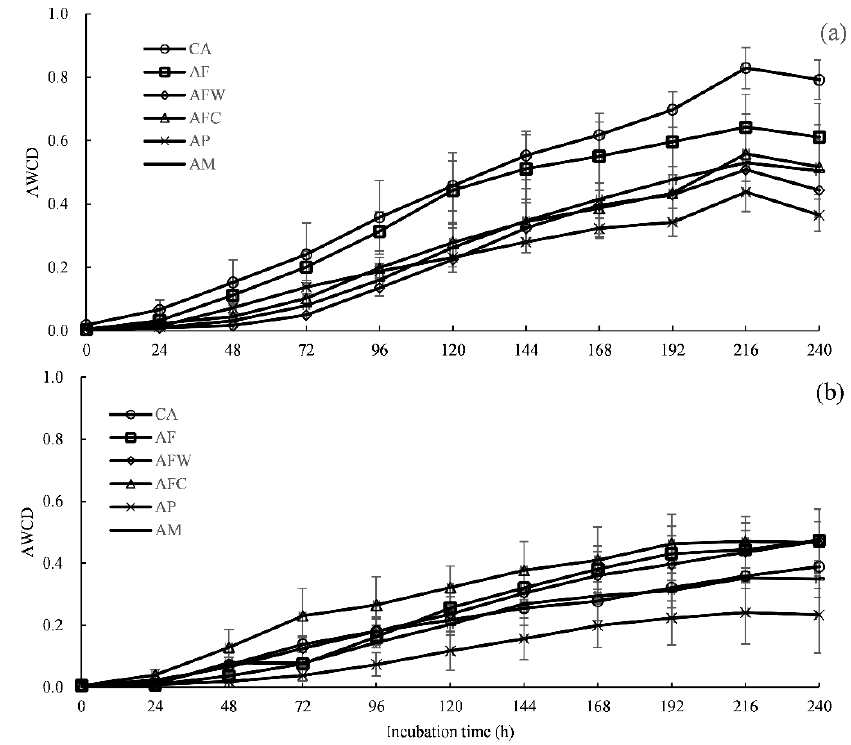
Figure 3. Average well-color development (AWCD) of soil microbial communities with incubation time in the topsoil ( a , 0-30 cm) and subsoil ( b , 30-60 cm) depth. Continuous alfalfa (CA), alfalfa-fallow (AF), alfalfa-fallow-wheat (AFW), alfalfa-fallow-maize (AFC), alfalfa-potato (AP), alfalfa-millet (AM).